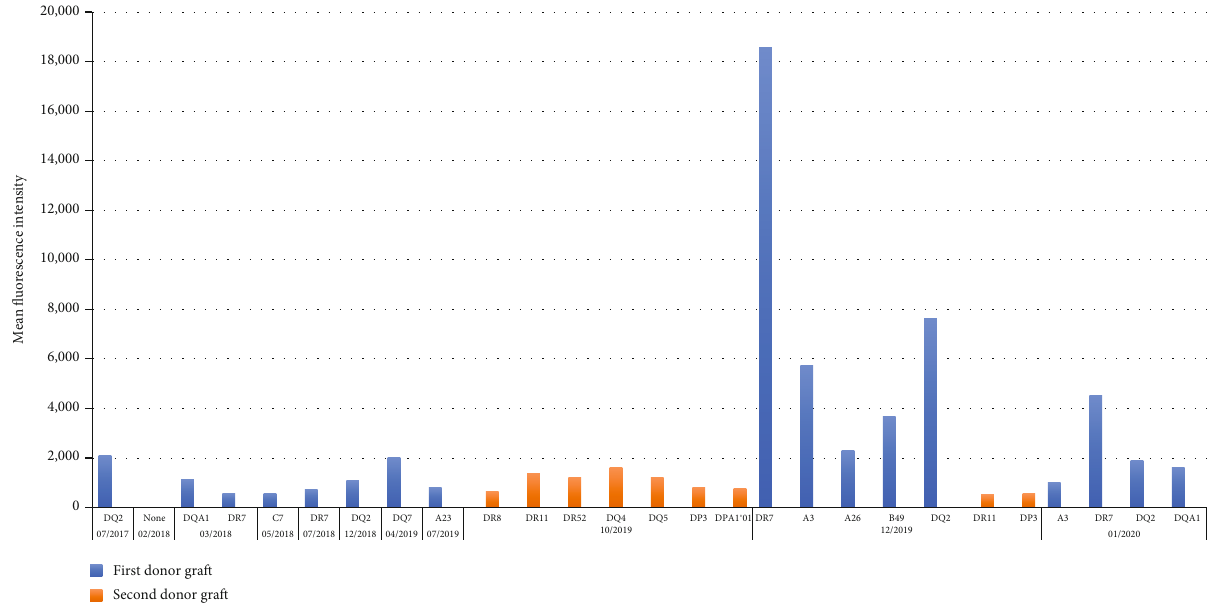
Figure 1: Mean fl uorescence intensity of posttransplant donor-speci fi c antibodies to donor human leukocyte antigens.